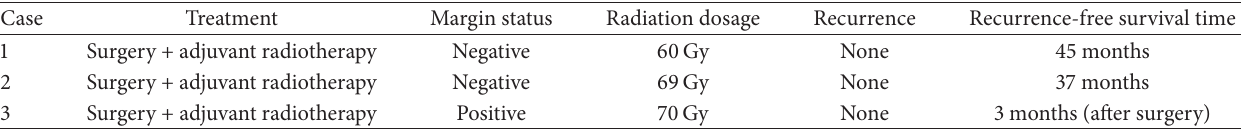
Table 2: Treatment and outcomes of the MPNST